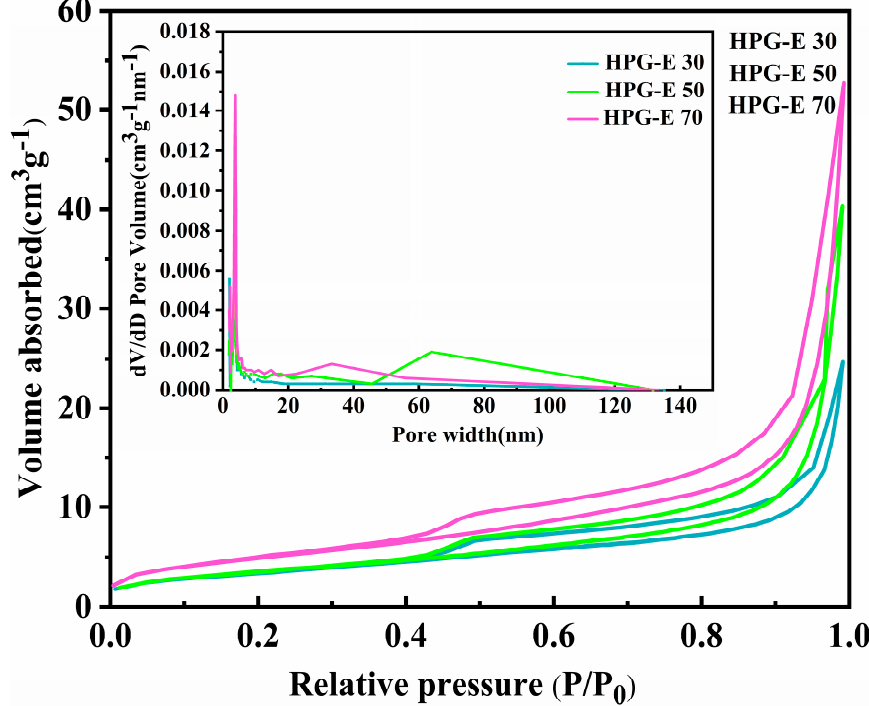
Figure 6. Nitrogen adsorption/desorption isotherms and pore diameter distribution (the inset is plotted using the BJH method). Table 6. N 2 gas adsorption-desorption analyses of the as-prepared samples. Samples